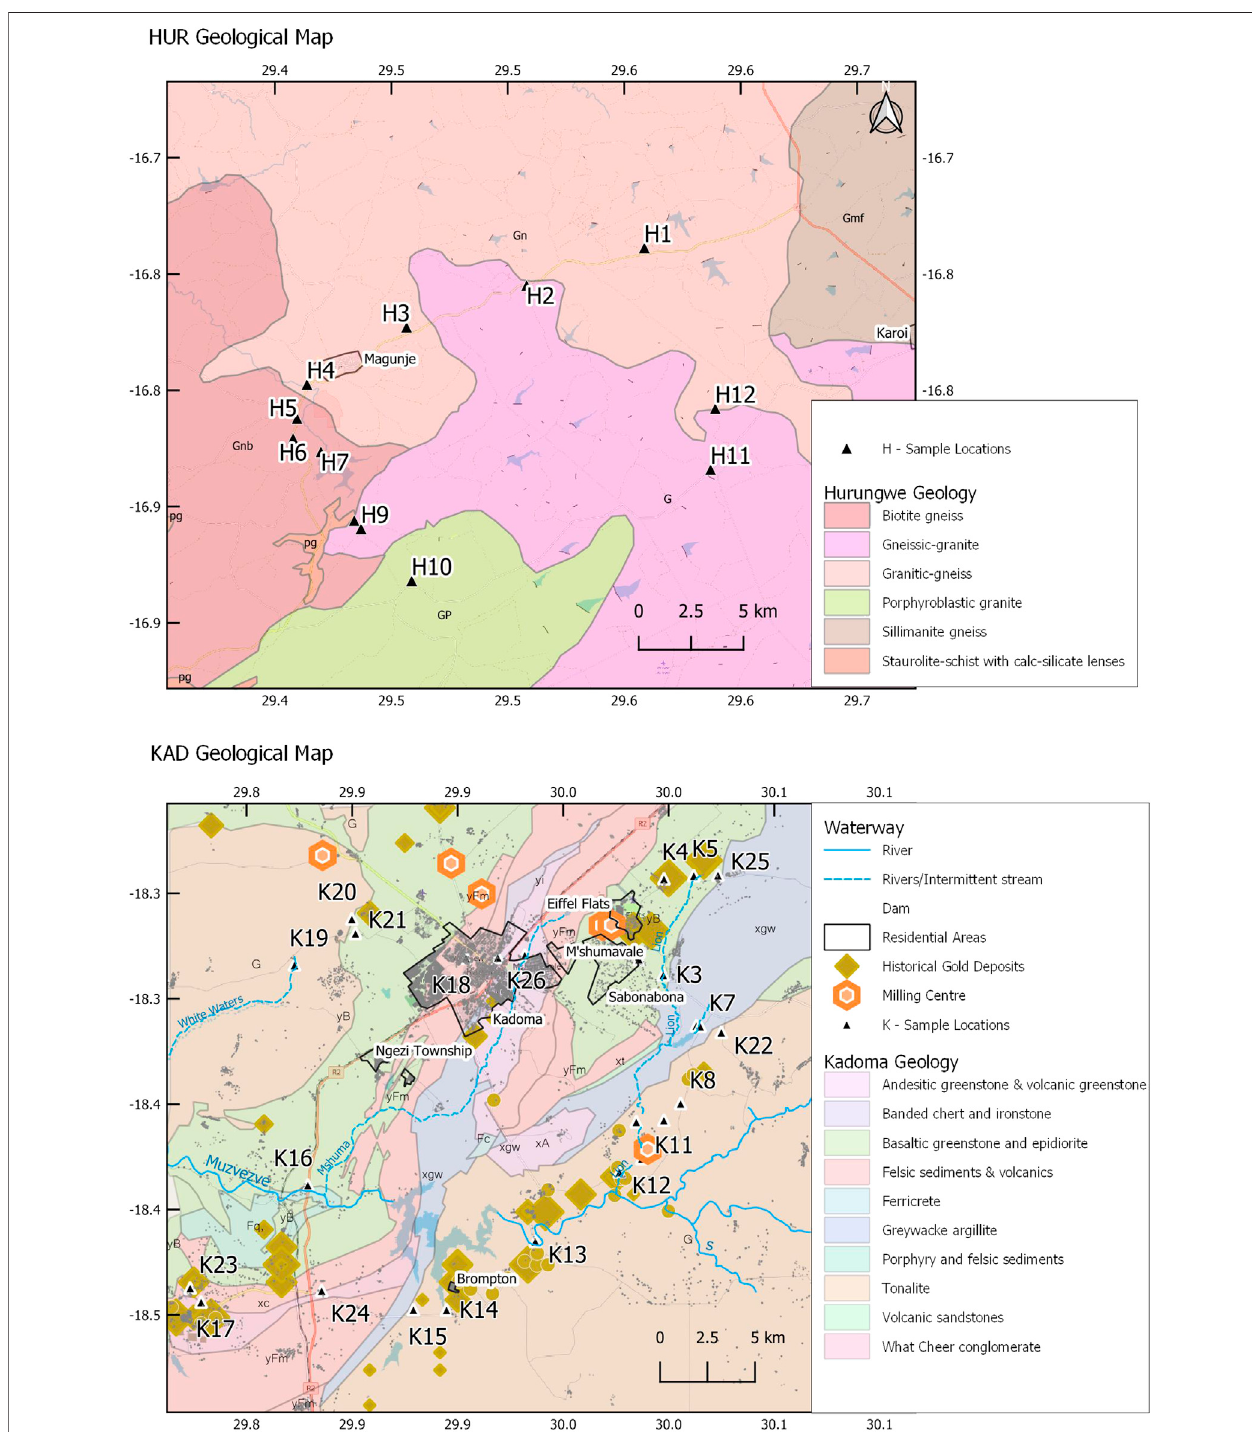
FIGURE 1 | Overview of the geology of the HUR and KAD areas showing details of the varying lithology for the sites.